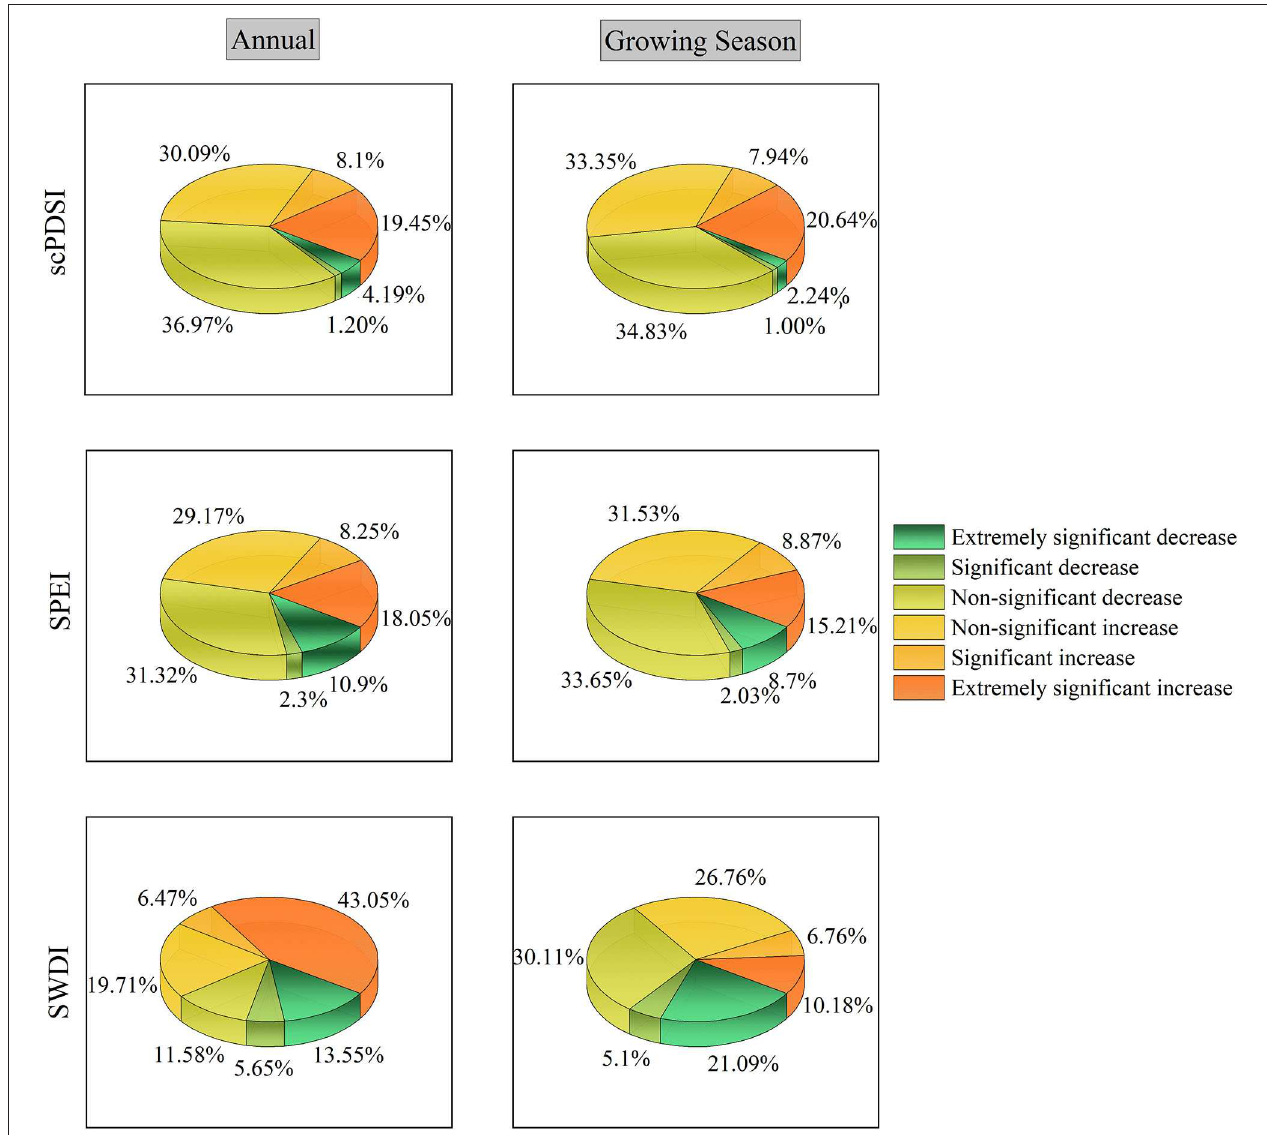
FIGURE 6 | Area proportions (%) occupied by different variation trends of the three drought